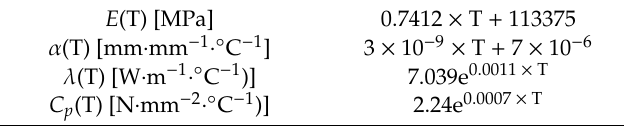
Table 2. Thermal and mechanical properties of Ti-6Al-4V with respect to temperature.